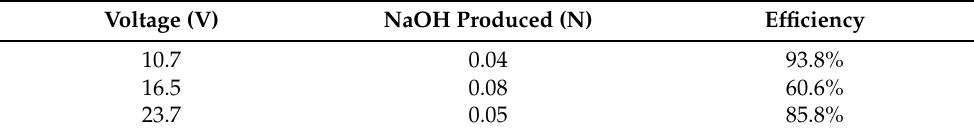
Table 3. Current